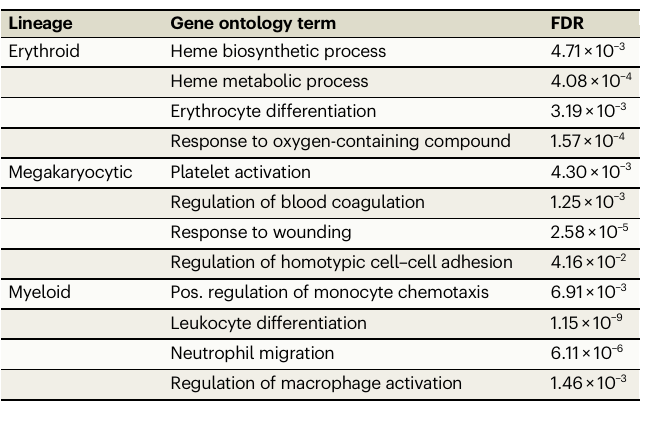
Table 1 | Lineage-speci fi c differentially expressed genes identi fi ed by CLIMB are enriched in gene ontology terms related to terminal cell function